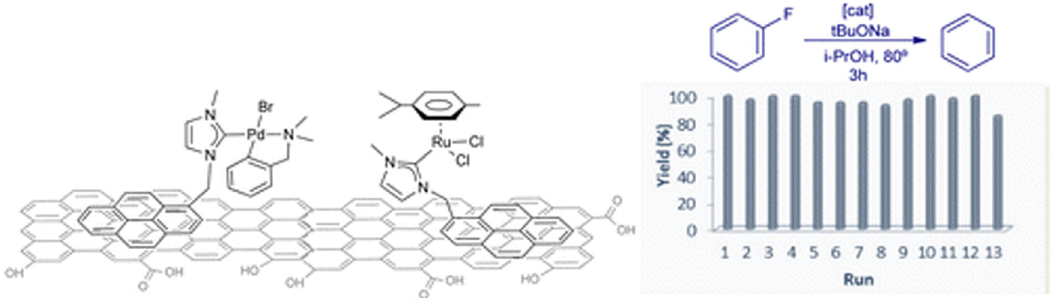
Figure 3: Immobilization of pyrene - tagged palladium and ruthenium complexes onto reduced graphene oxide for hydrode fl uorination. Reprinted ( adapted ) with permission from American Chemical Society ” ref. [ 131 ] Organometallics 2015;34 ( 7 ) :1186 – 90. https://doi.org/10. 1021/om501040x. Copyright @2014 American Chemical